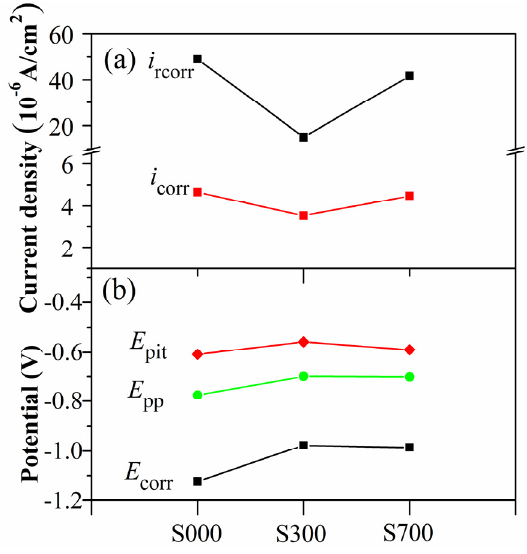
Figure 5. Parameters of the polarization obtained from Figure 4: ( a ) corrosion current density ( i corr ) and recorrosion current density i rcorr ; ( b ) corrosion potential ( E corr ), pitting potential ( E pit ) and protection potential ( E pp